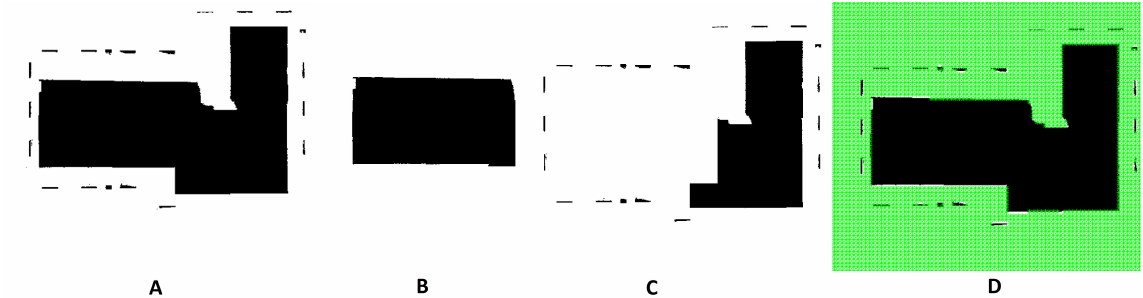
Figure 5. The map of the refectory and other buildings with their surrounding objects in the simulation space ( A ); the refectory building map ( B ); the obstacle map ( C ); the initial sample viewpoints on the map ( D